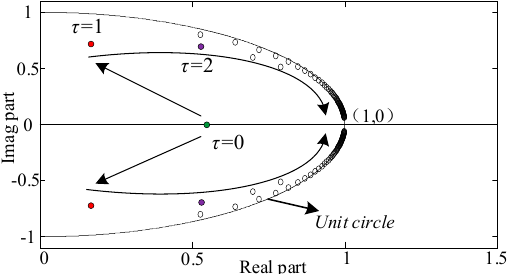
Figure 4. Distribution of eigenvalues with different time delay.